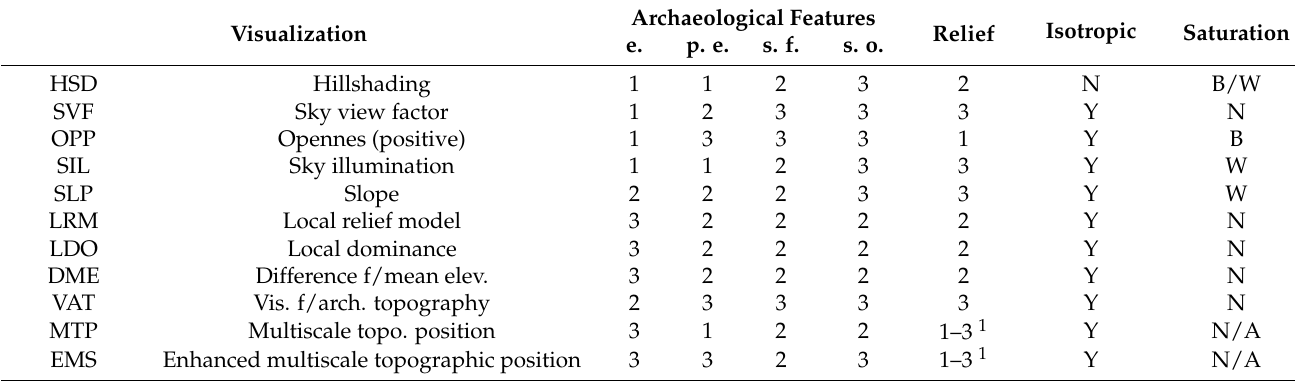
Table 2. Qualitative assessment (based on the subjective experience of the authors) of visualizations commonly used in archaeology-specific workflows (compare to [33]). Table heading, archaeological features: e.—embedded; p. e.—partially embedded; s. f.—standing features; s. o.—standing objects (see Figure 2). Table body: 1—poor; 2—medium; 3—good; Y—yes; N—no; W—white (0% black); B—black (100% black); N—neutral, no